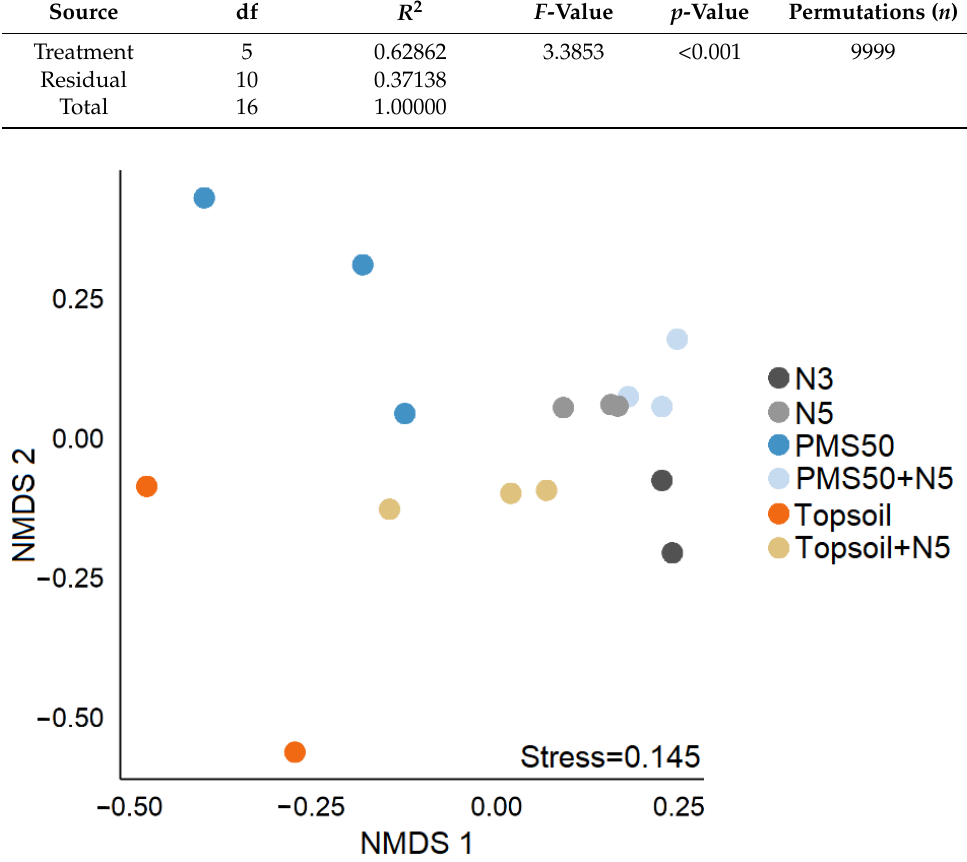
Figure 5. Non-metric multidimensional scaling (NMDS) representation of community structure on the according to amendment application (N3, N5, PMS50, PMS50+N5, topsoil, topsoil+N5) at the Mont-Wright site.